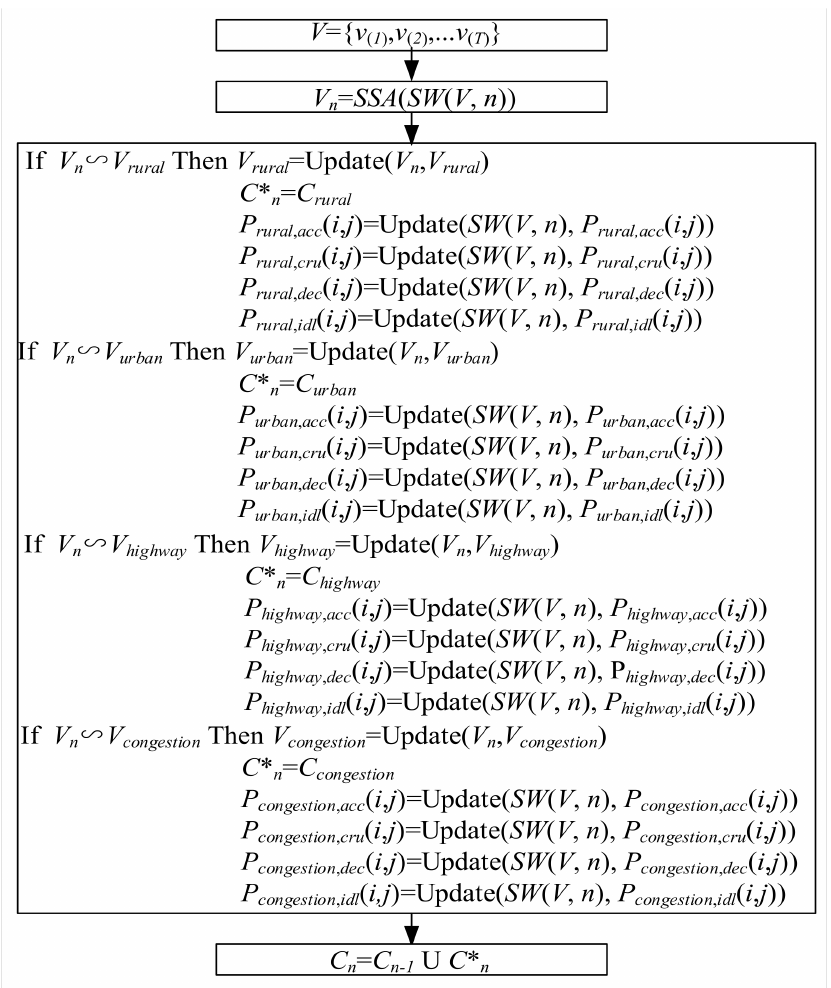
Figure 8. Calculate DS label sequence and state transition probability